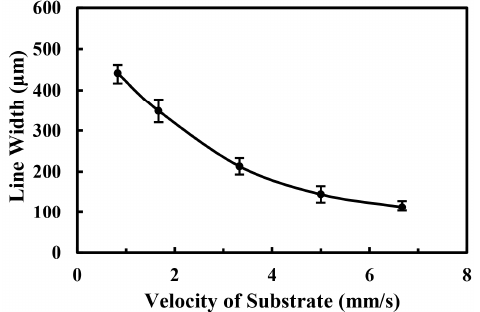
Figure 6. The effect of the velocity of substrate on the electrospray line width. The applied voltage, the flow rate of solution, the distance between nozzle and collector and the deposition time were 1.5 kV, 50 μ L/h, 5 mm, and 2 s, respectively.